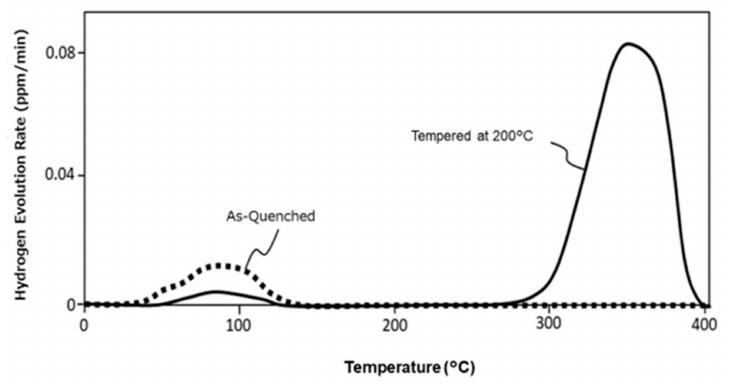
Figure 1. Hydrogen-evolution curves of steel specimens with martensitic structure. The dotted line represents the quenched specimen, and the solid line represents the quench-tempered